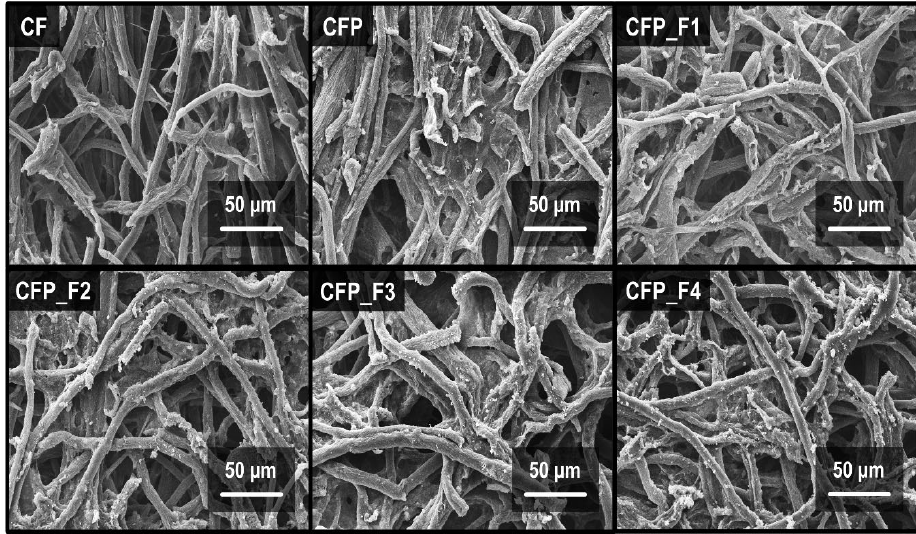
Figure 2. SEM images of CF, CFP, and CFP_F1-F4 samples. Table 2. EDX Element analysis of the CF and CFP samples.